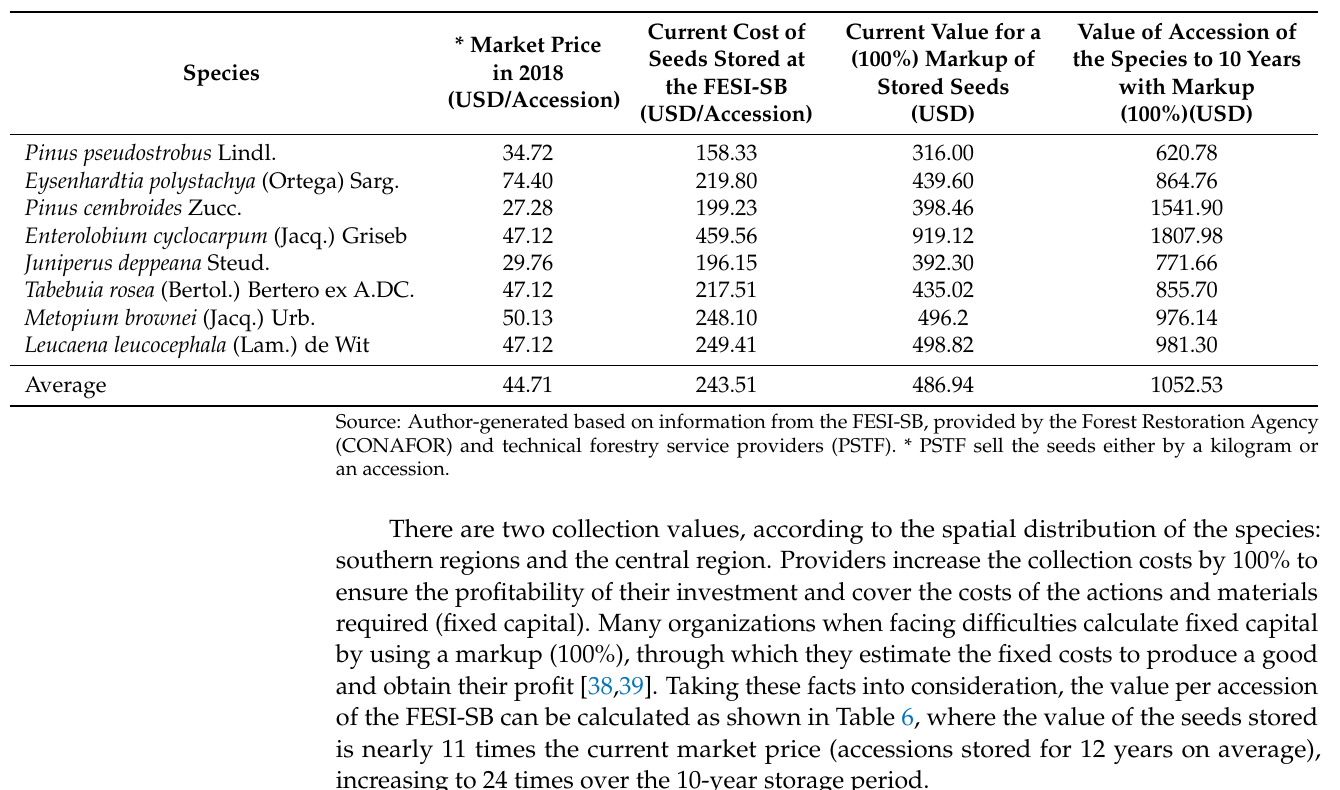
Table 6. Market price of seeds versus collection and storage costs in the